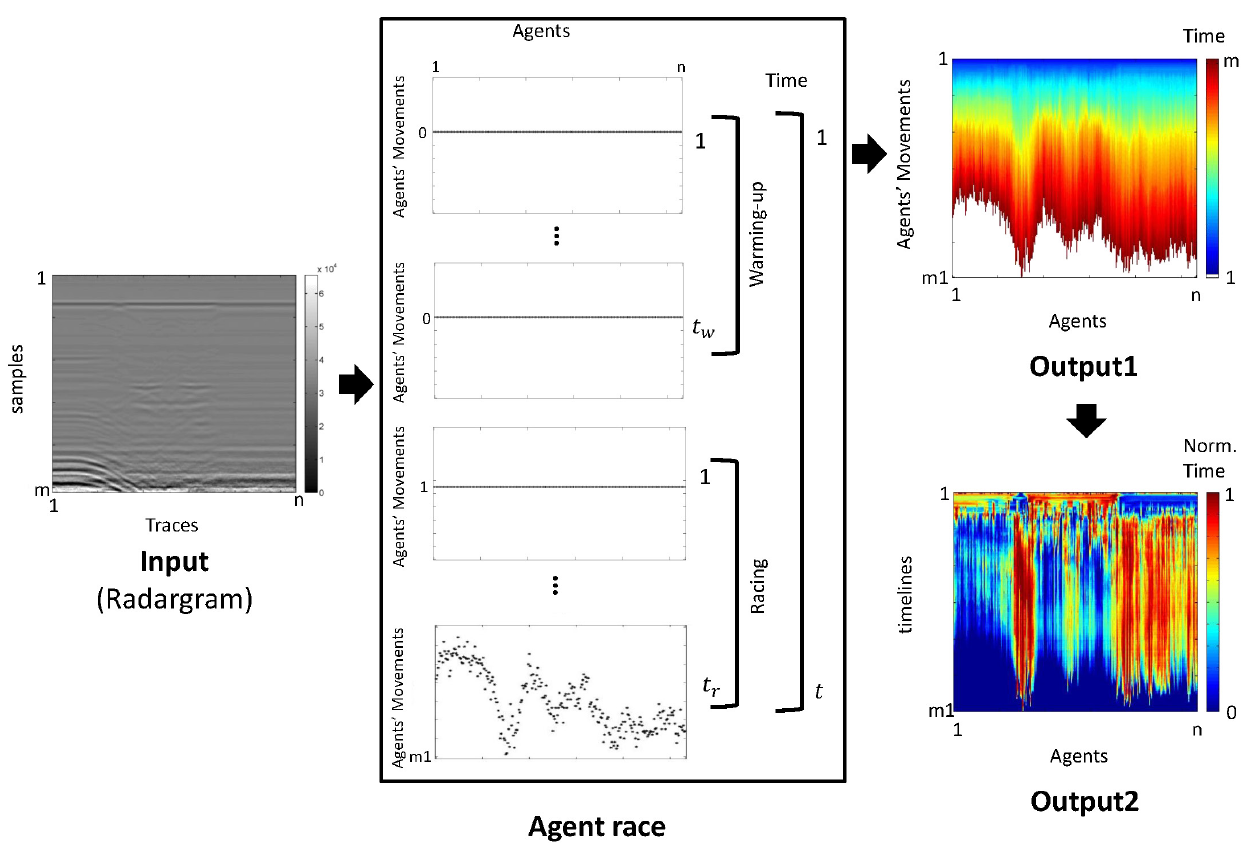
Figure 10. Scheme for the agent-race